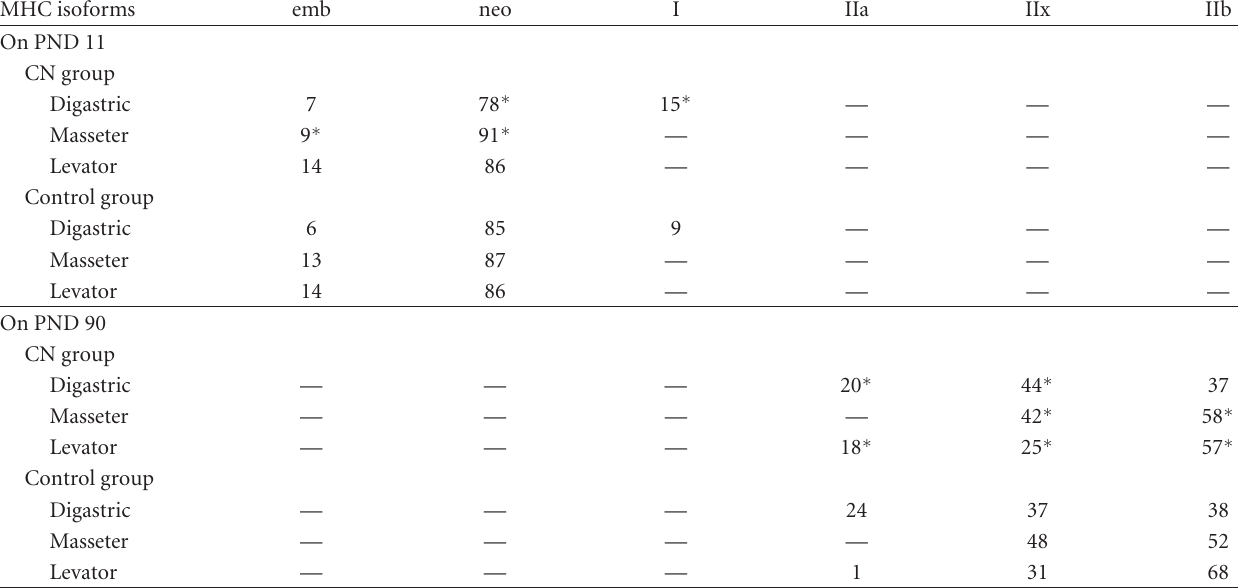
Table 1: Distribution of myosin heavy chain (MHC) isoforms in selected oral ( digastric, masseter ) and nasal ( levator ) muscles in rats exposed to an early episode of forced oral breathing (CN group) and in control rats [74]. The di ff erent MHC isoforms were characterized on PND 11 and 90 (for key to the functions of the di ff erent MHC isoforms, see the text). Short-term nasal obstruction, that is forced oral breathing, leads to long-term orofacial muscle fibre adaptation. We observed increases in MHC neonatal and adult type I isoforms in muscles involved with oral breathing, digastric, and masseter , in CN group versus control on PND11. No changes were observed in the levator muscle involved with nasal breathing on PND 11. There are increases in MHC adult type IIb isoforms in muscle involved with oral breathing, masseter , and in muscle involved with nasal breathing, levator , in CN group versus control on PND 90. Values are given as percentages of total MHC and comparisons were then made using t -test with the Bonferroni